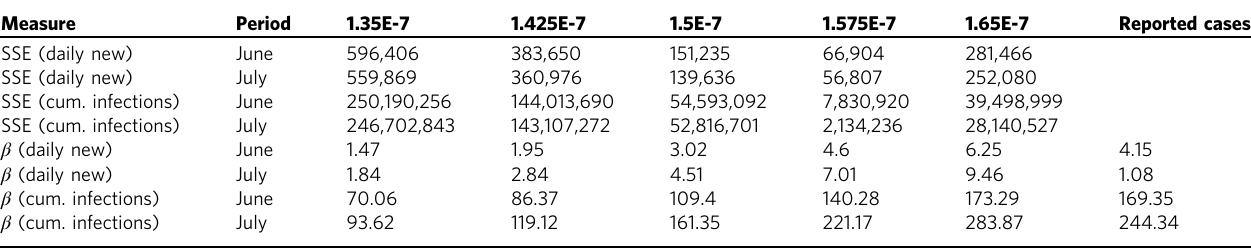
Table 5 Evaluation of the different calibration scenarios using the squared sum of errors (SSEs) and the slope of a regression line ( β